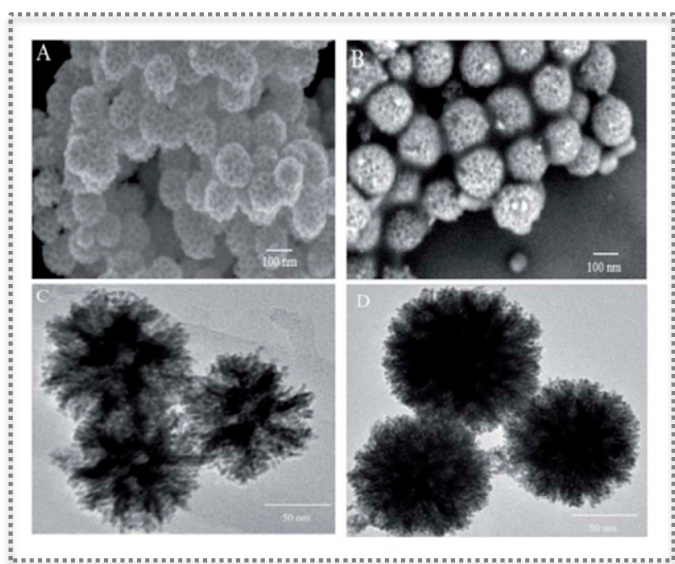
Figure 10. Characterization of molecular imprinting on PtPd NFs showing spherical nanostructure with flower-like morphology and mesoporous on the surface: SEM images of PtPdNFs ( A ) and T- MIP-PtPd NFs ( B ); TEM imagens of PtPd NFs ( C ) and T-MIP-PtPd NFs ( D ). (Reproduced under